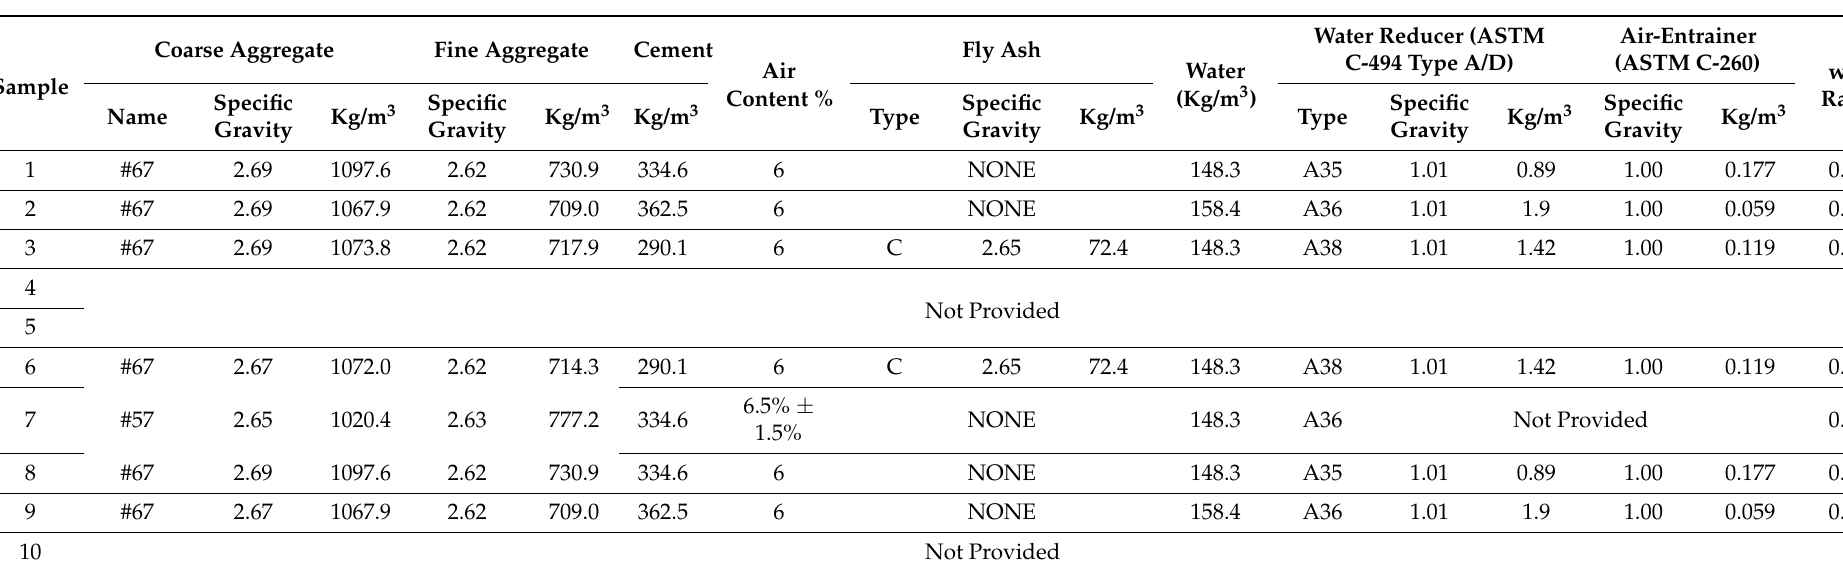
Table A1. Mix design of field concrete